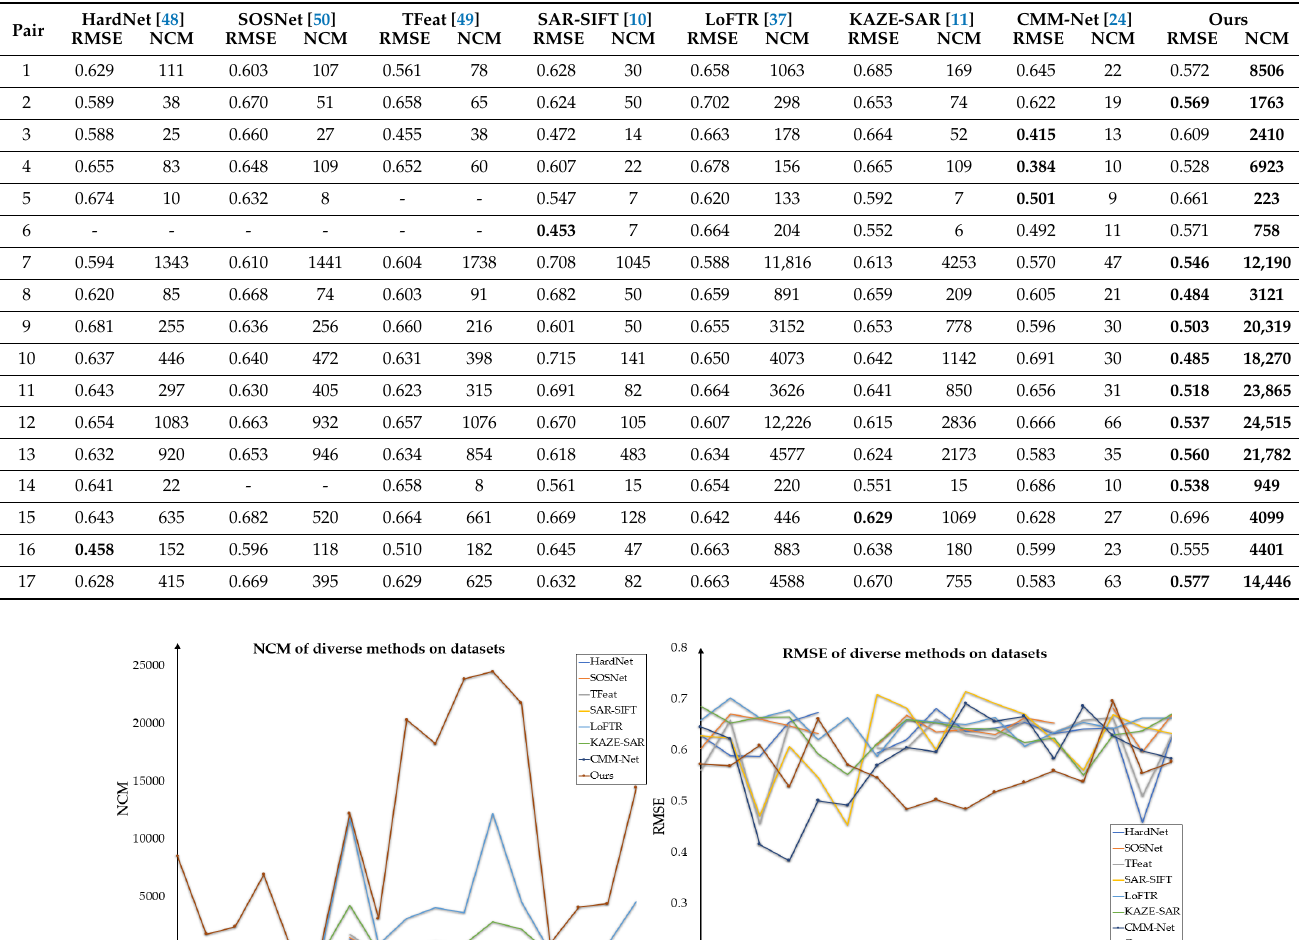
Figure 9. NCM and RMSE of diverse methods on the datasets.